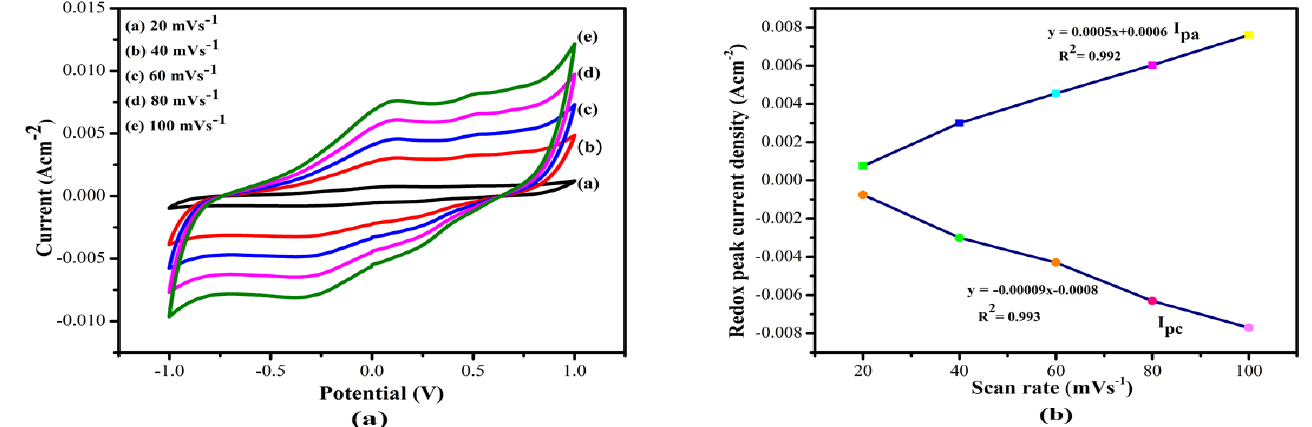
Figure 10. ( a ) Cyclic voltammograms of GCE/(MWCNT/ZnS/AgNWs/PANI/Frt/GOx at different scan rates ranging from 20 – 100 mV s −1 in the presence of 50 mM glucose. ( b ) Redox peaks calibration curve of the corresponding bioanode with the expansion in scan rate (20 – 100 mV s −1 ). Further, the kinetics of the modified anode in terms of rate constant (ks) was evalu- ated to be 5.8 s −1 at 100 mV s −1 by using a prevalent Laviron Equation (1) [44]. A compari- son of the current density and the rate constant of the given modified bioanode with the reported ones is shown in Table 1 [38,44 – 51].